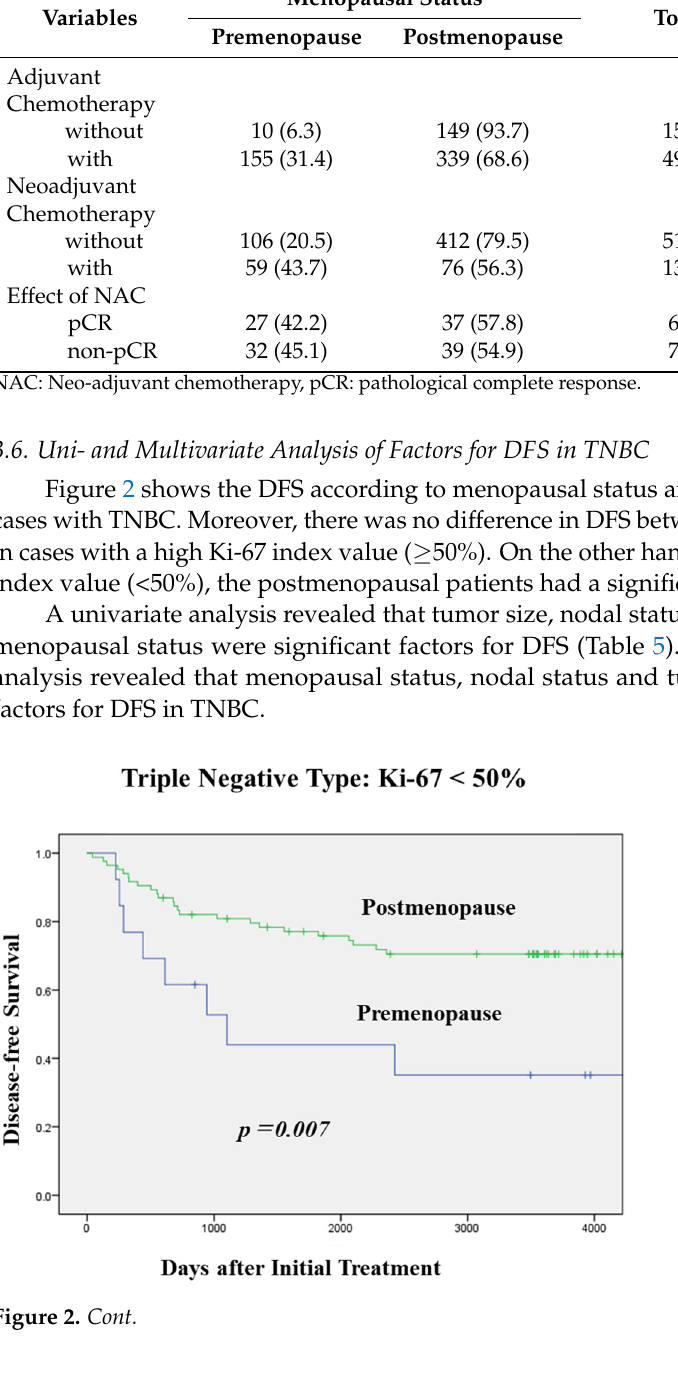
Table 4. Pre- and Post-Operative Adjuvant Chemotherapy and Menopausal Status in TNBC. Variables